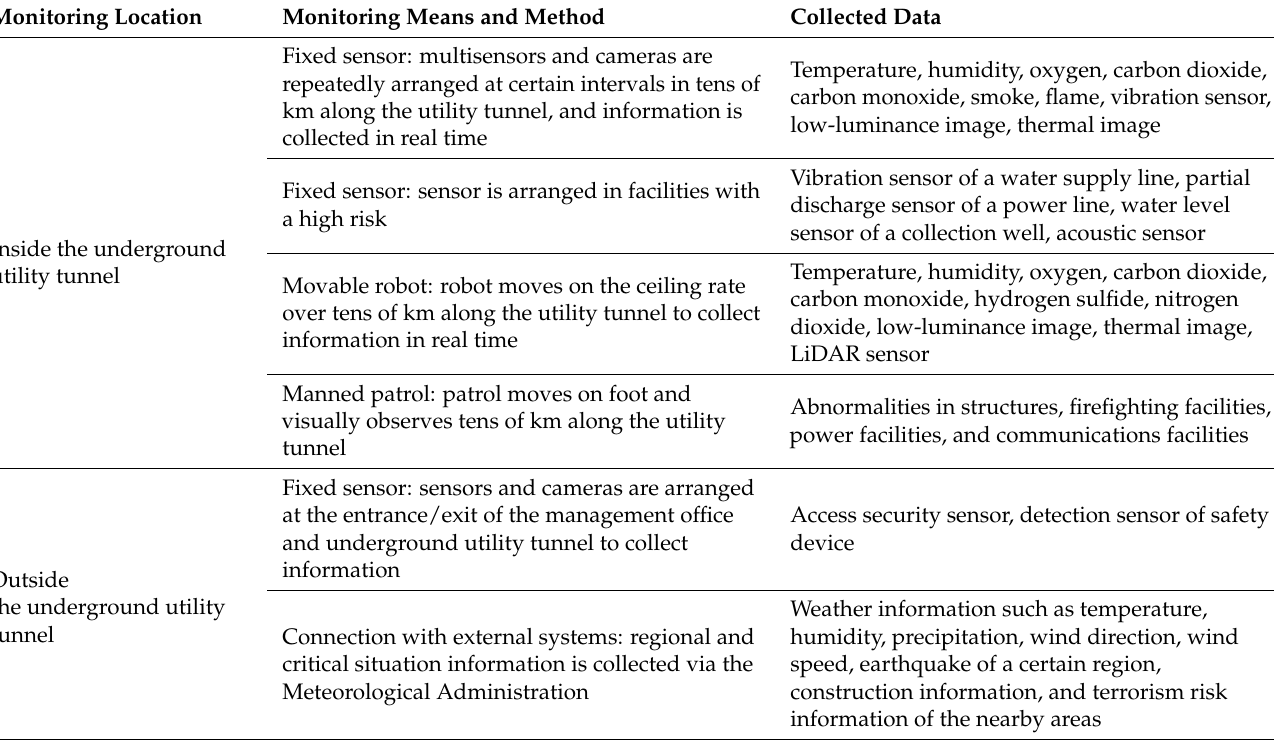
Table 5. Overview of site information collection for underground utility